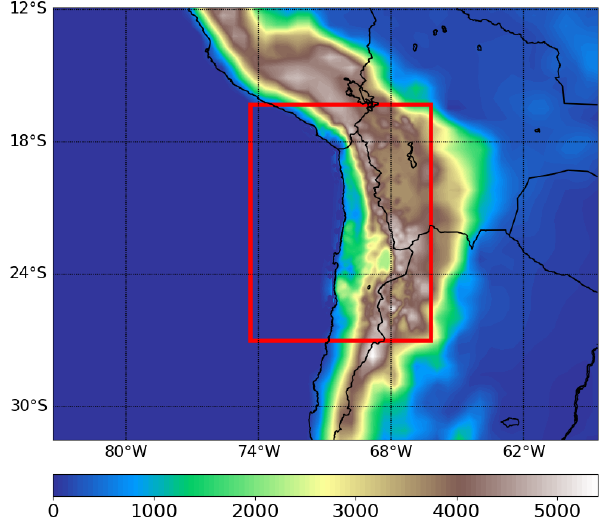
Figure 1. Map showing the outer (50km × 50km resolution) and inner WRF model domain (red box, 10km × 10km resolution) and the topographic heights (shading, in